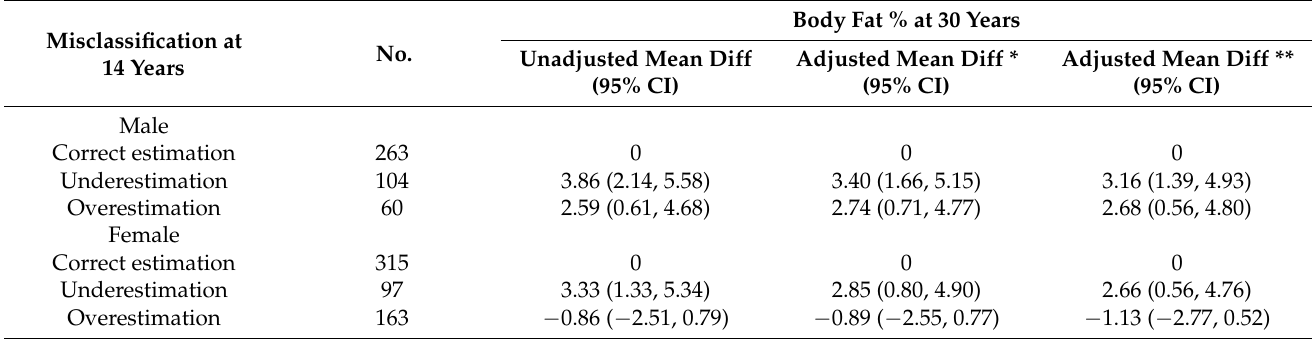
Table 2. Mean difference and 95% confidence interval of body weight misclassification at the 14-year follow-up with body fat percentages at the 30-year